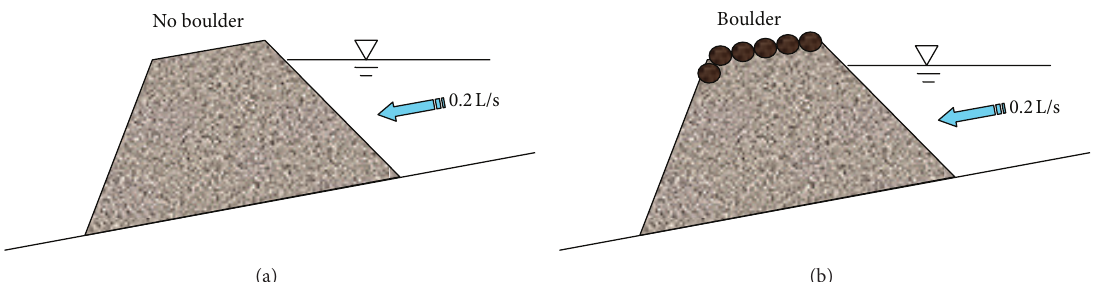
Figure 6: Experimental schemes for the impact of boulder at the topper